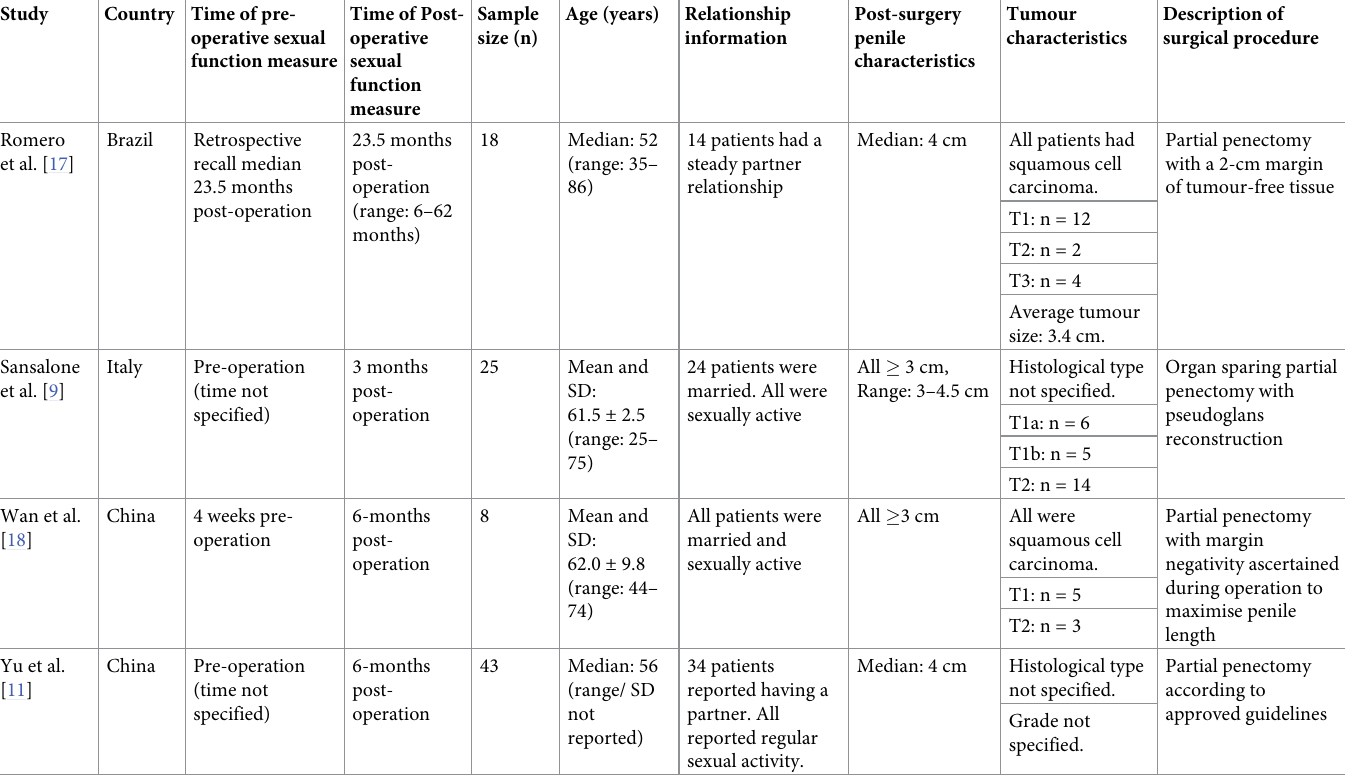
Table 1. Characteristics of studies exploring effects of partial penectomy for penile cancer on sexual function.